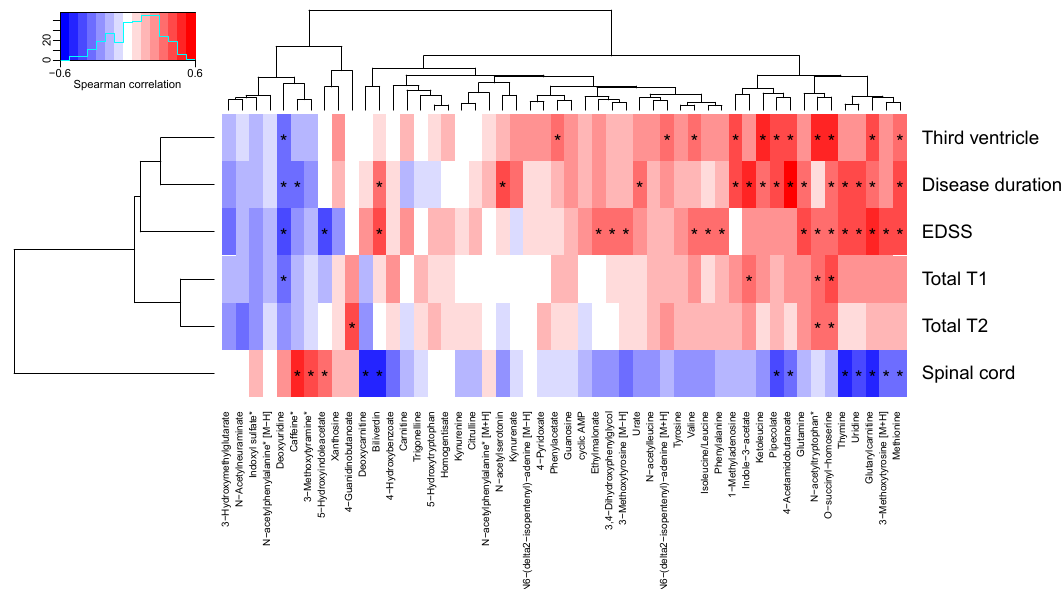
Figure 3. Associations between altered metabolites and clinical data. Metabolite names marked with an asterisk have been corrected for age. Correlations marked with an asterisk are statistically significant ( p < 0.05). EDSS: Expanded Disability Status